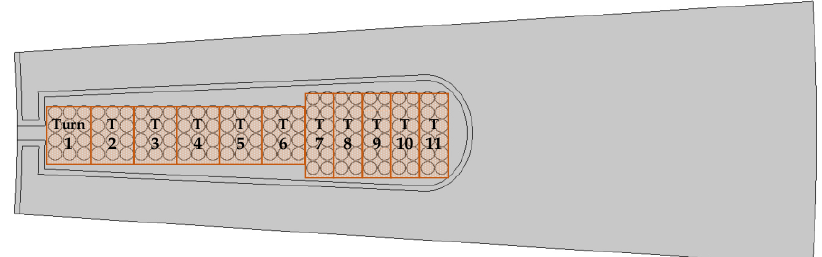
Figure 10. The location of 11 turns in a slot.